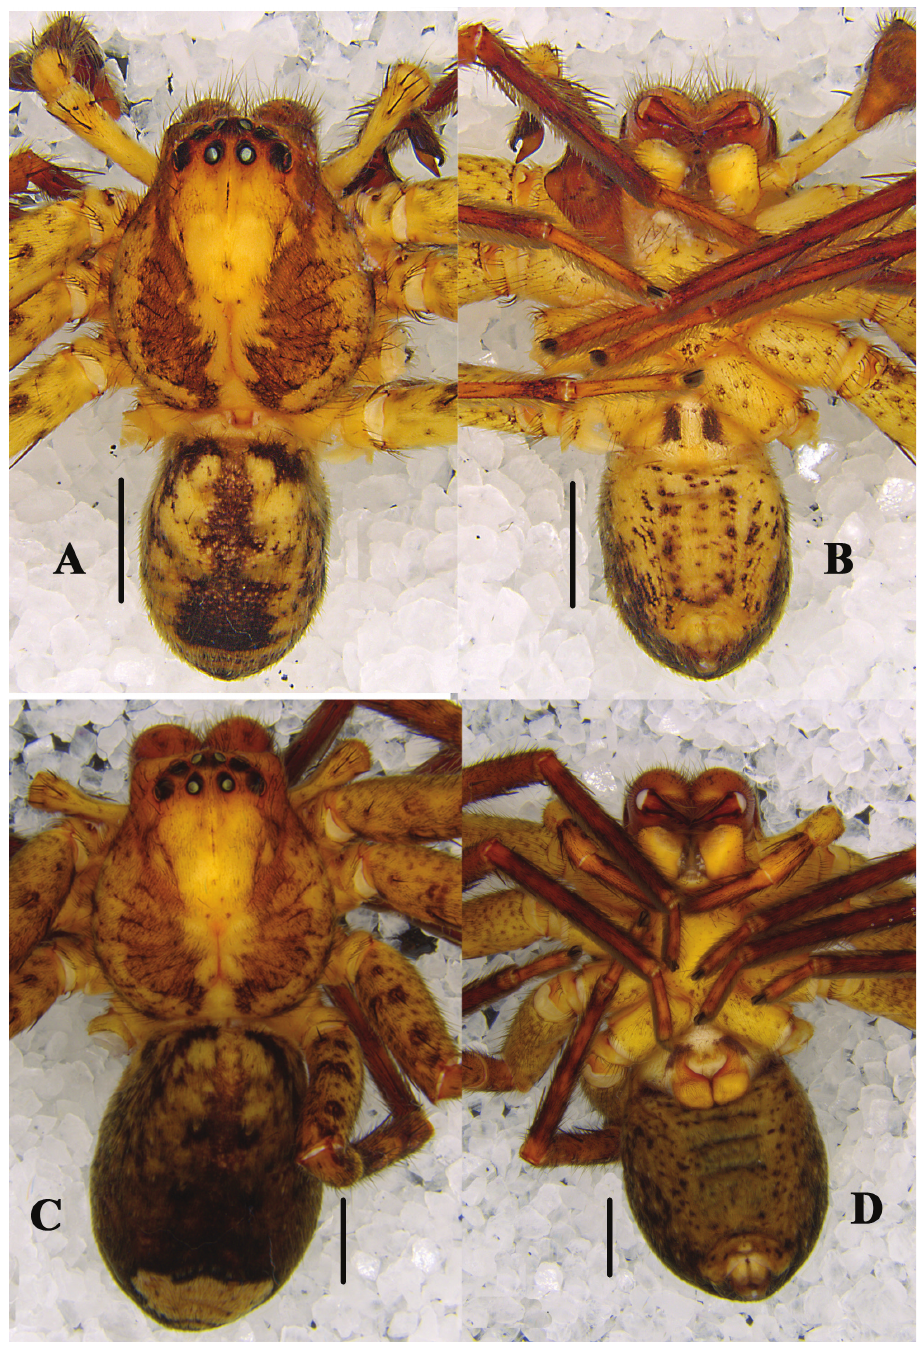
Figure 14. Pseudopoda signata Jäger, 2001 A, B male habitus ( A dorsal B ventral) C, D female habitus ( C dorsal D ventral). Scale bars: 2